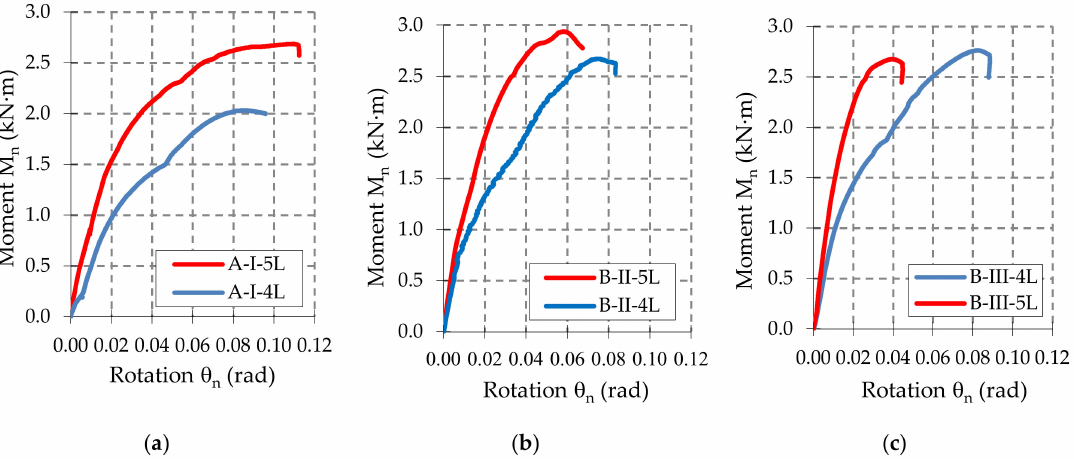
Figure 10. Comparison of the moment-rotation curves recorded for: ( a ) B-I-4L and B-I-5L assemblies, ( b ) B-II-4L and B-II-5L assemblies, and ( c ) B-III-4L and B-III-5L